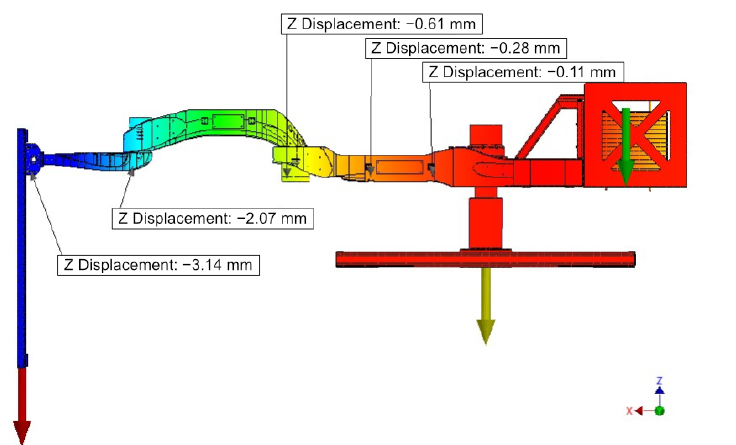
Figure 1. Results of predicted displacements from the design of the experimental arm, taking into account the deformation of individual parts of the arm and yielding in the axes of